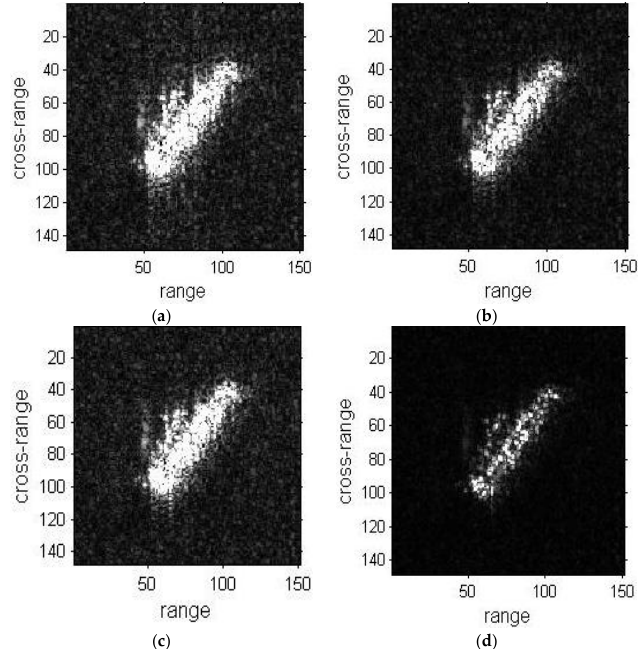
Figure 7. Refocused images of ship02 sub-image. ( a ) Sub-image of ship02; ( b ) Refocused image with the DCT method; ( c ) Refocused image with the PGA method; ( d ) Refocused image with the proposed method.